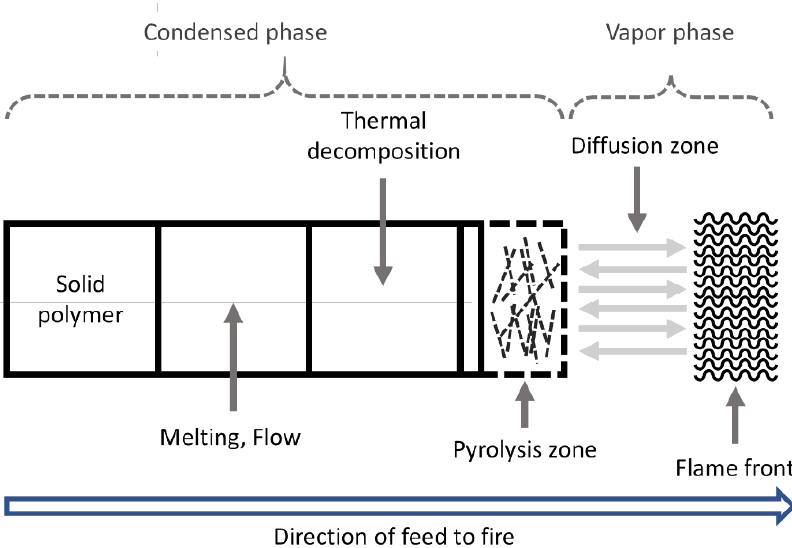
Figure 5. Schematic of polymer decomposition and combustion behavior. Reproduced with permis- sion from Ref. [49]. Copyright 2012, John Wiley & Sons, Ltd.